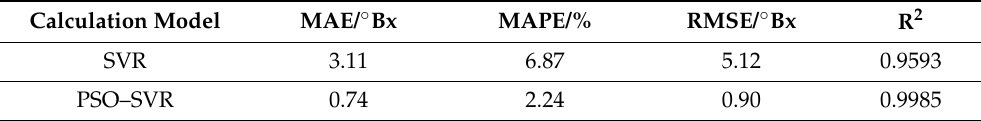
Table 6. Evaluation index of syrup brix measurement based on SVR and PSO–SVR.